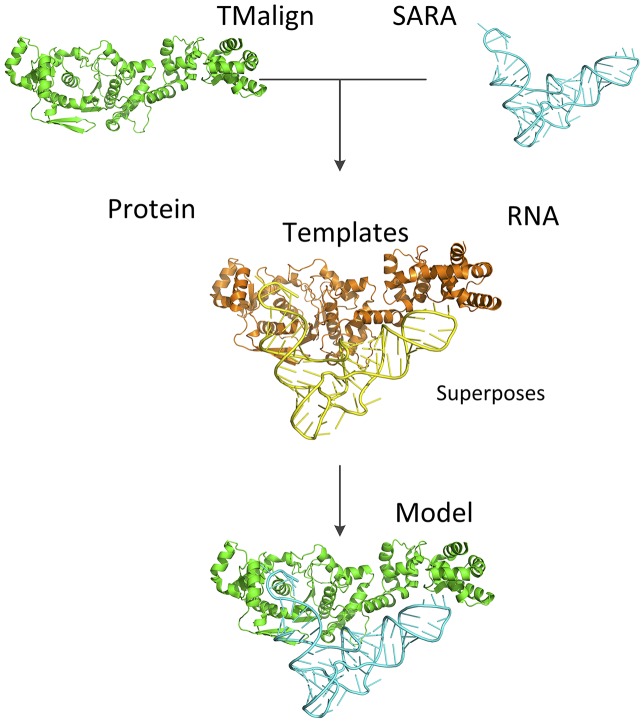
Protein-RNA modeling procedure.The input protein and RNA structures are aligned to the templates by TM-align and SARA correspondingly. The models of the complex are sorted by the complex structural score (see text).